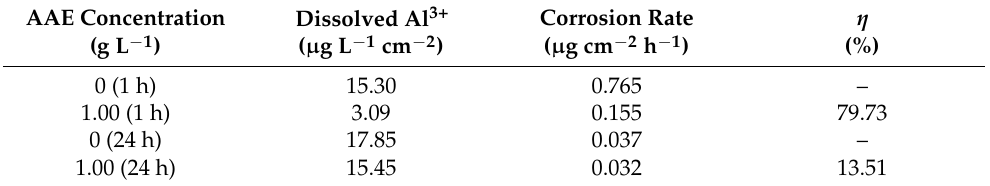
Table 5. Effect of the AAE on corrosion of aluminium alloy 5083 in ASW as determined by ICP-OES. AAE